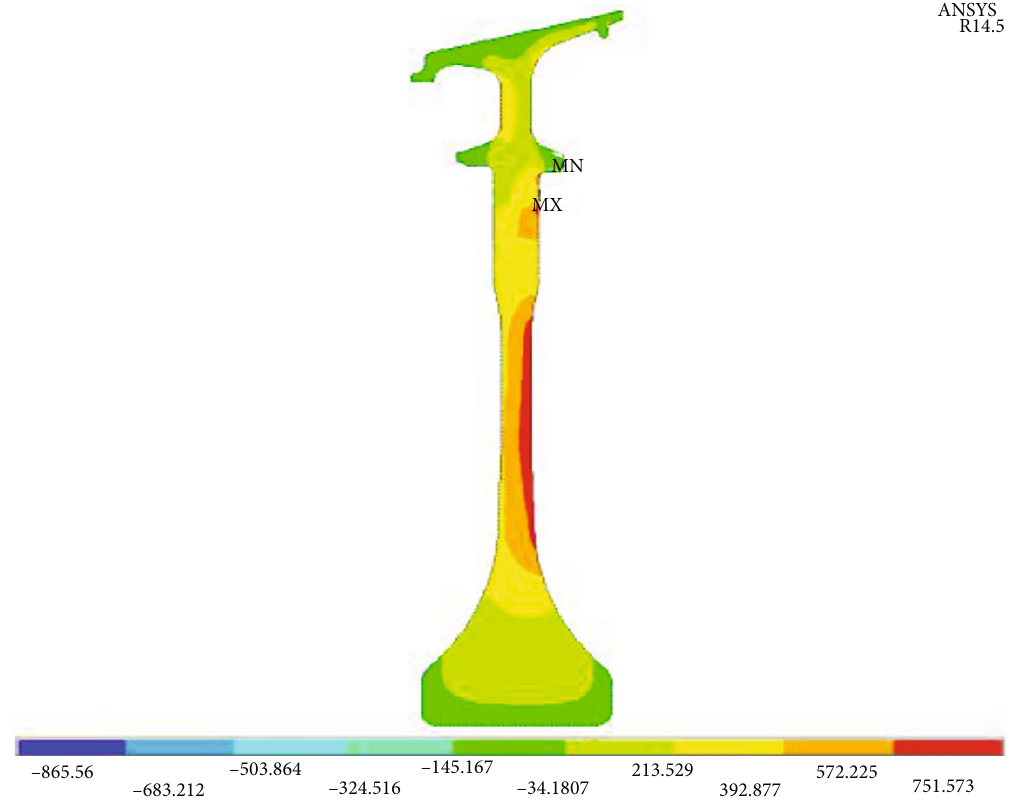
Figure 8: Radial stress distribution.